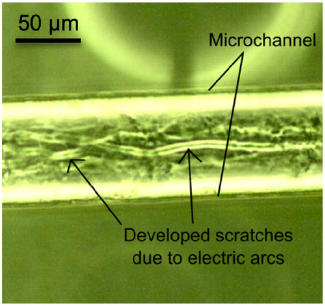
Figure 7. An optical microscope image of a microchannel showing damage of the microchannel surface from electric arcs generated with an applied voltage of 1800 V (electric field over 225 kV/m).